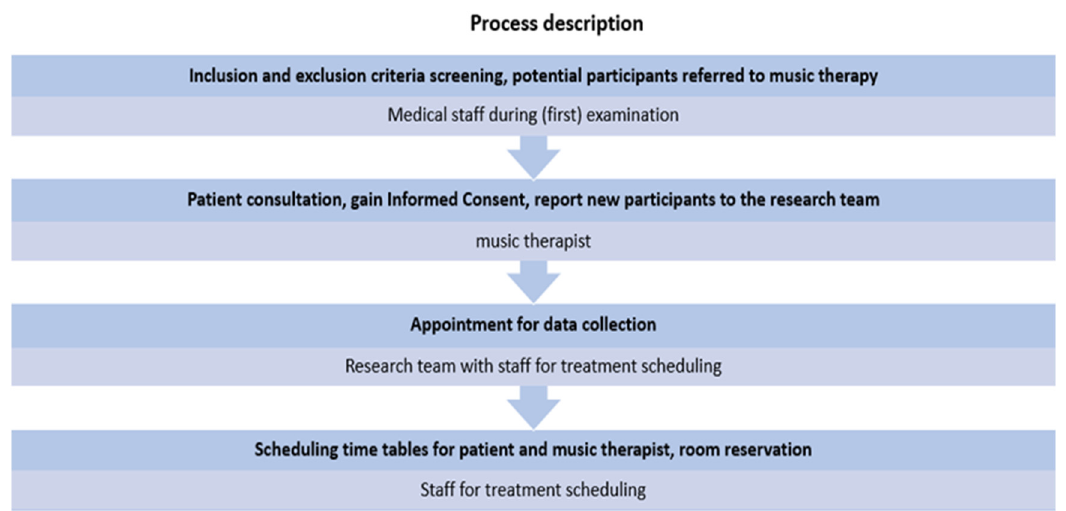
Figure 1. Recruitment process description.